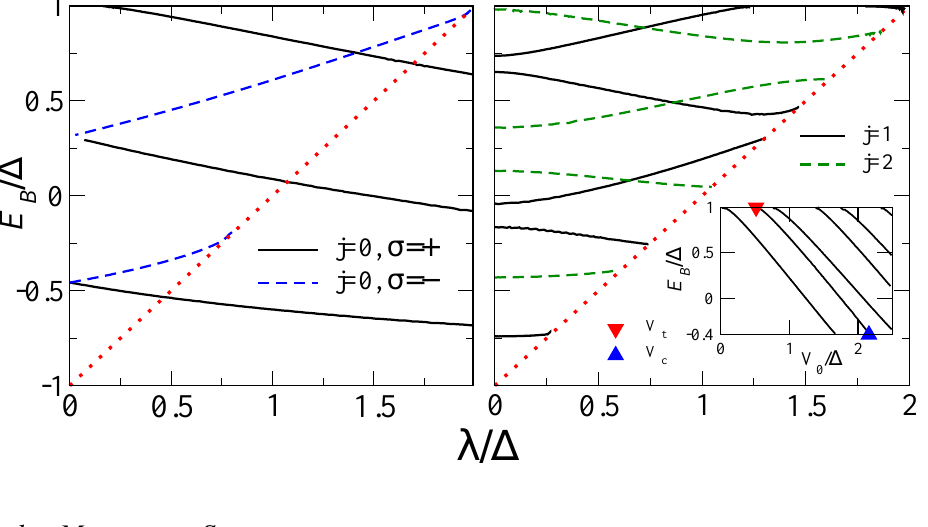
Figure 1. Bound-state spectrum ( E ) vs . Rashba SOI ( λ ) for a circular potential well B = 2∆ and radius R = 3 / ∆ . Only the lowest-energy states with j = 0 , 1 , 2 are with depth V 0 = − ∆+ λ . The left panel shows j = 0 bound states shown. The red dotted line indicates E + with parity σ = ± . The right panel shows j = 1 , 2 bound states. The inset displays the j = 1 bound-state energies vs . potential depth V for λ = 0 . 6∆ . At some threshold value V 0 = 0 for the lowest state shown), a new bound state emerges from the conduction (where V t band. This state dives into the valence band for some critical value V = E = − 0 . 4∆ . For the second bound state in the inset, valence band edge is at energy E B + V ( V ) is shown as red (blue) t c